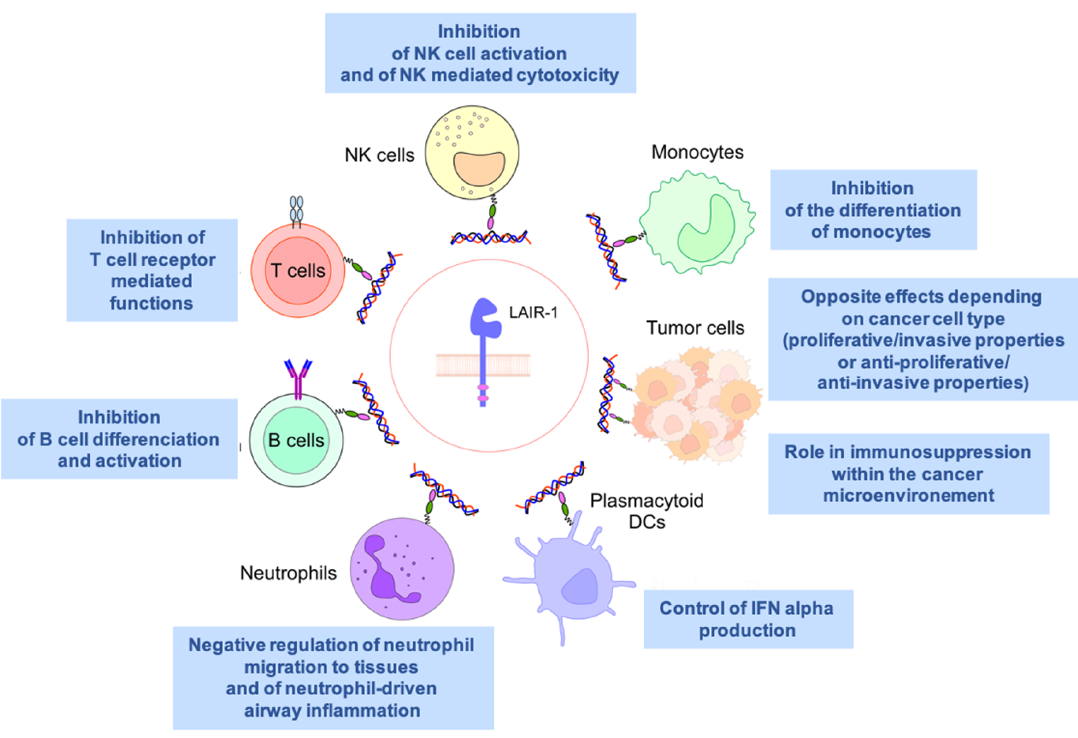
Figure 1. Summary of LAIR1 expression and functions in normal leucocytes, plasmacytoid dendritic (pDCs) cells, and tumor cells.